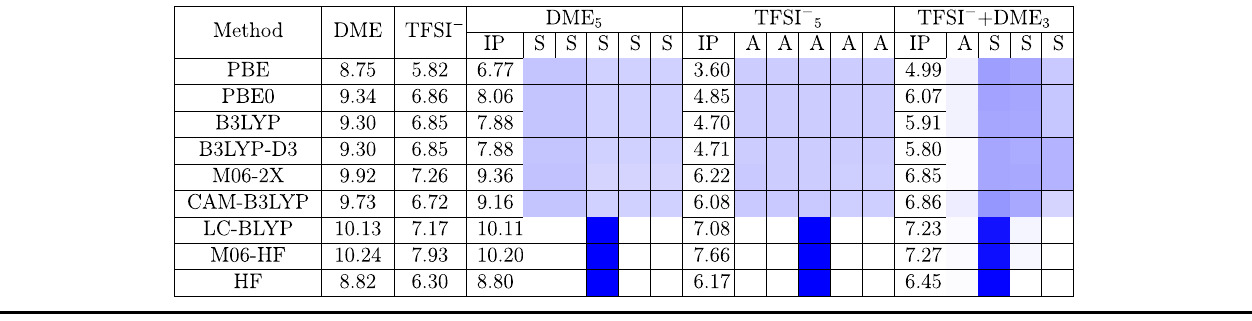
For reference, in the case of DME, the experimental IP is 9.8eV and our calculated DLPNO-CCSD(T) IP is 9.9eV. For TFSI − our calculated DLPNO-CCSD(T) IP is 7.3eV. These values are reported in Supplementary Table 8. Columns 2 and 3 refer to isolated DME and TFSI − , respectively. Columns 4 – 9: fi ve identical DMEs 10Å apart. Columns 10 – 15: fi ve identical TFSI − molecules 500Å